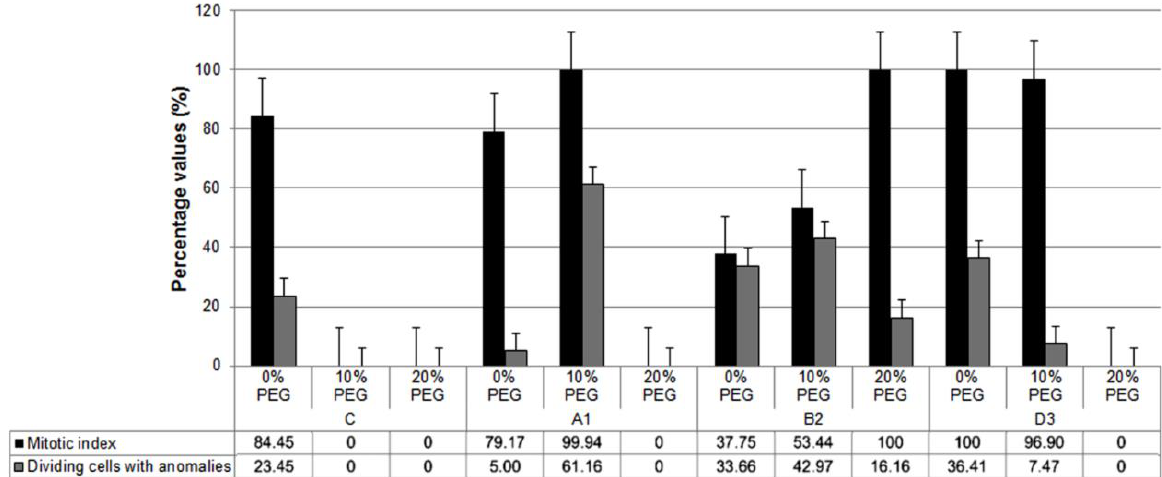
Figure 2. Mean values of mitotic index (MI) and dividing cells with anomalies (DCA) determined per stand × PEG treatment interaction. Results are expressed in percentage ± standard error (S.E.).